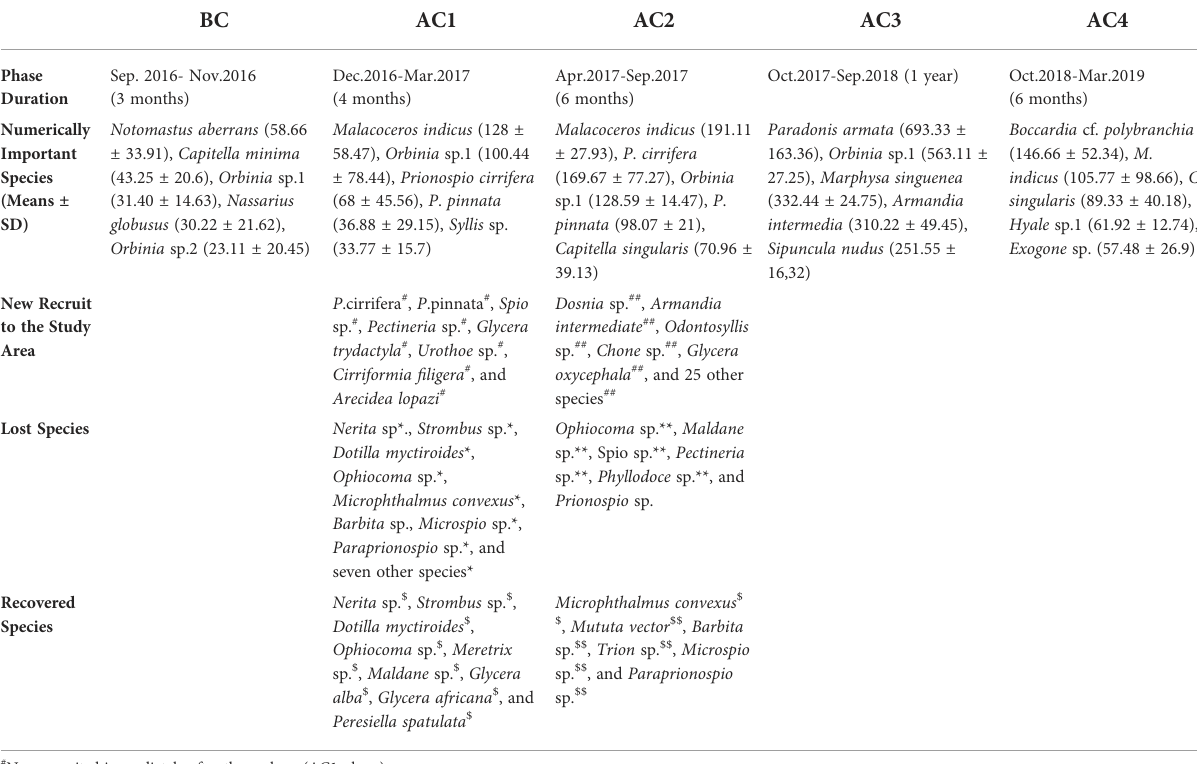
TABLE 1 Summary of numerically important species, species that lost due to cyclone and recovered, and new recruit to the station. BC